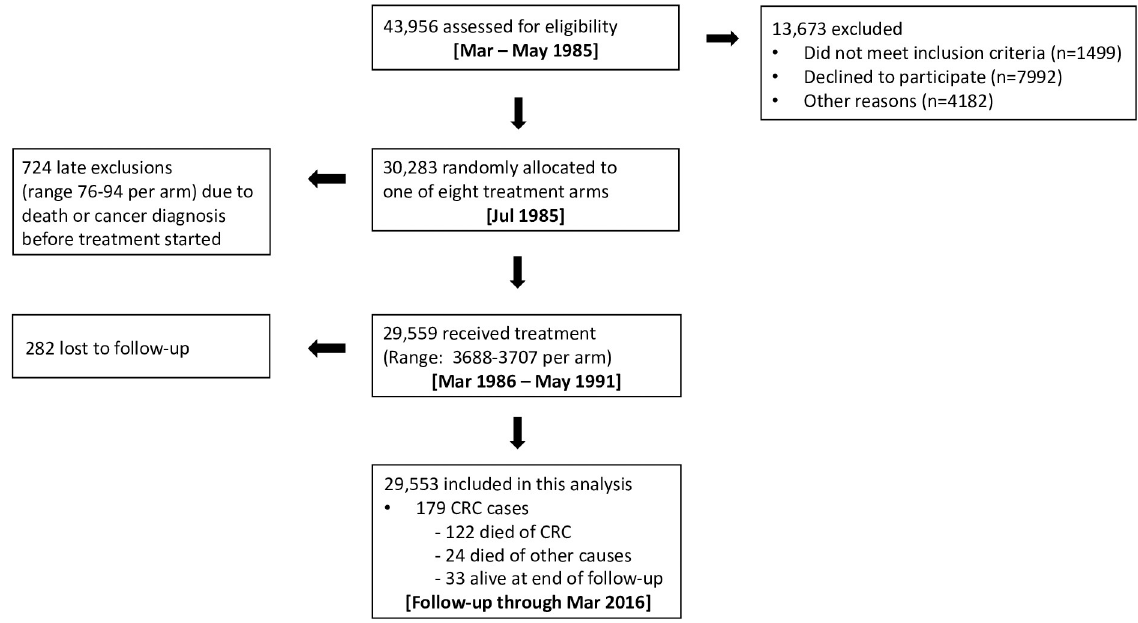
Fig 1. CONSORT trial flow diagram of the Linxian general population trial.